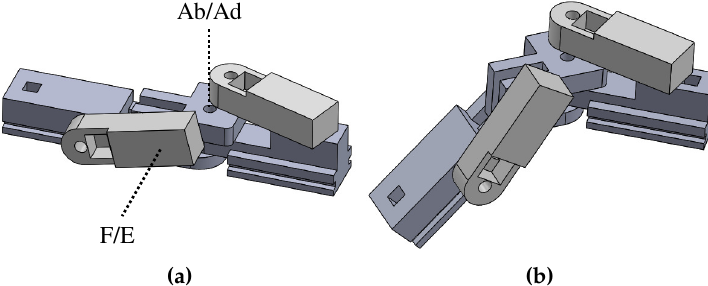
Figure 5. Structure design for metacarpophalangeal (MCP) joint (measurement of F/E and Ab/Ad motions); ( a ) Initial position; ( b )